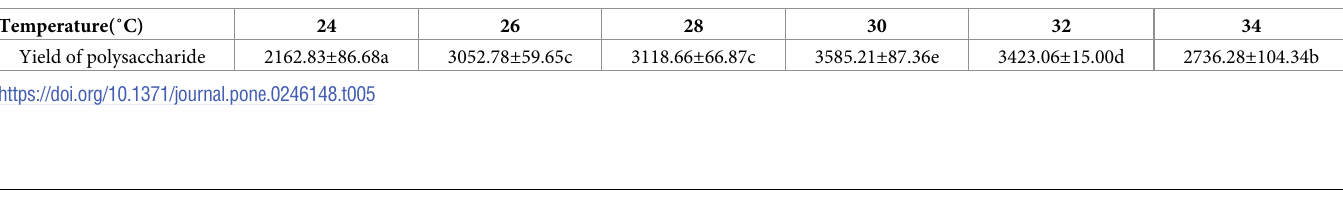
Table 5. Effect of different temperature on the yield of MRYP